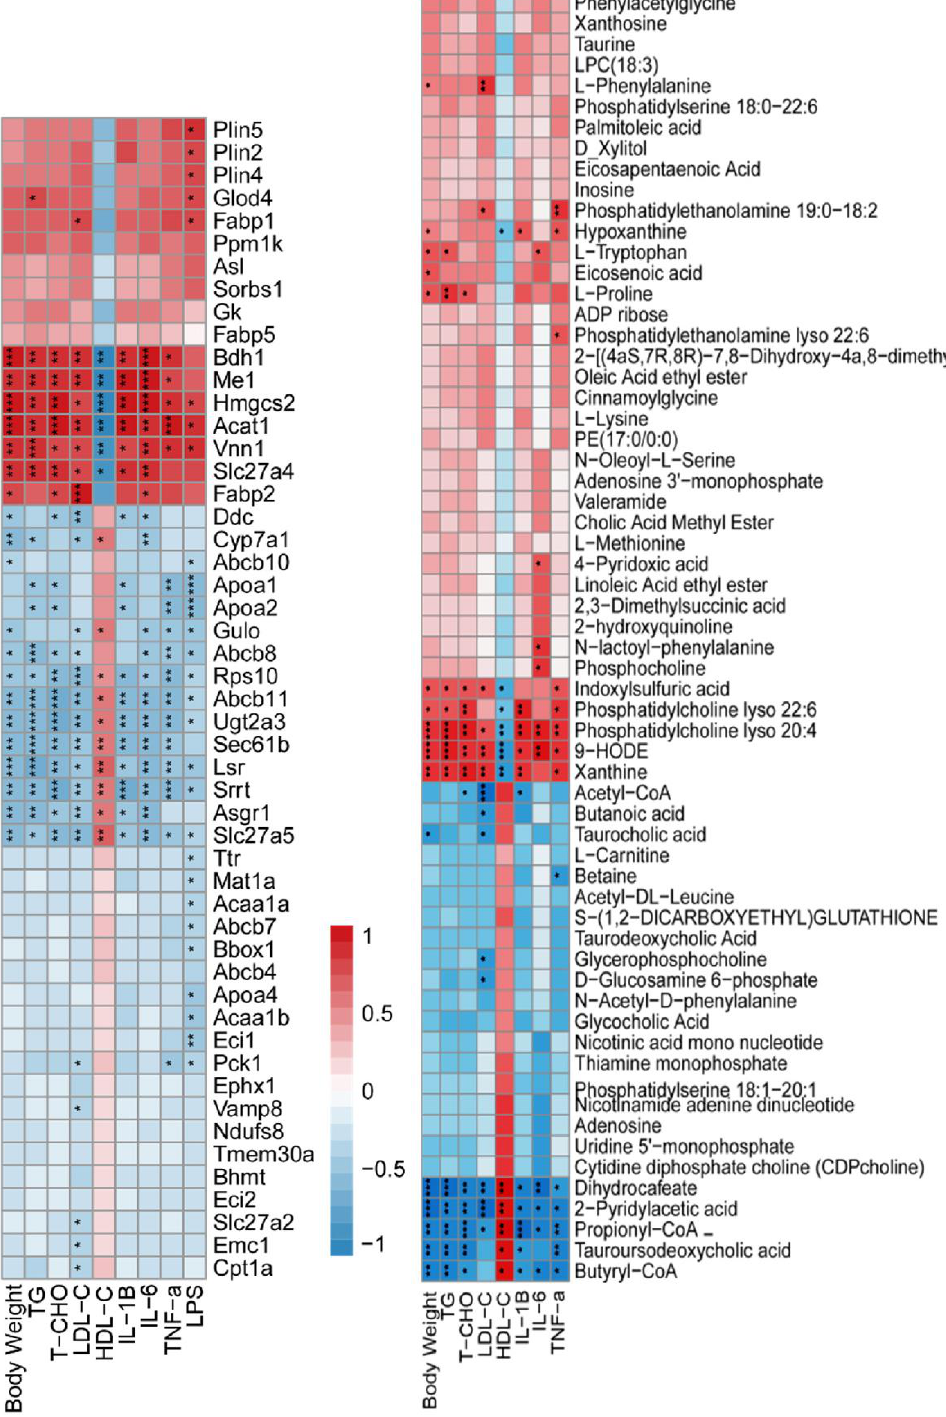
Figure 6. The correlation heatmap of the phenotypic properties of body weight, TG, TC, LDL-c, HDL-c, IL-6, IL-1 β , and TNF- α with DEPs ( left panel ) and metabolites ( right panel ). The HDLc with unique association with DEPs and metabolites was demonstrated, and the significance of correlation as * p < 0.05, ** p < 0.01, and *** p < 0.001.